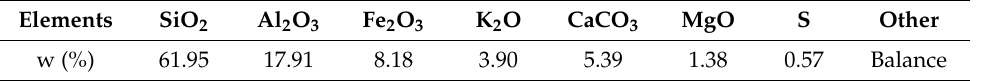
Table 1. Lightweight expanded clay (LECA) chemical composition.